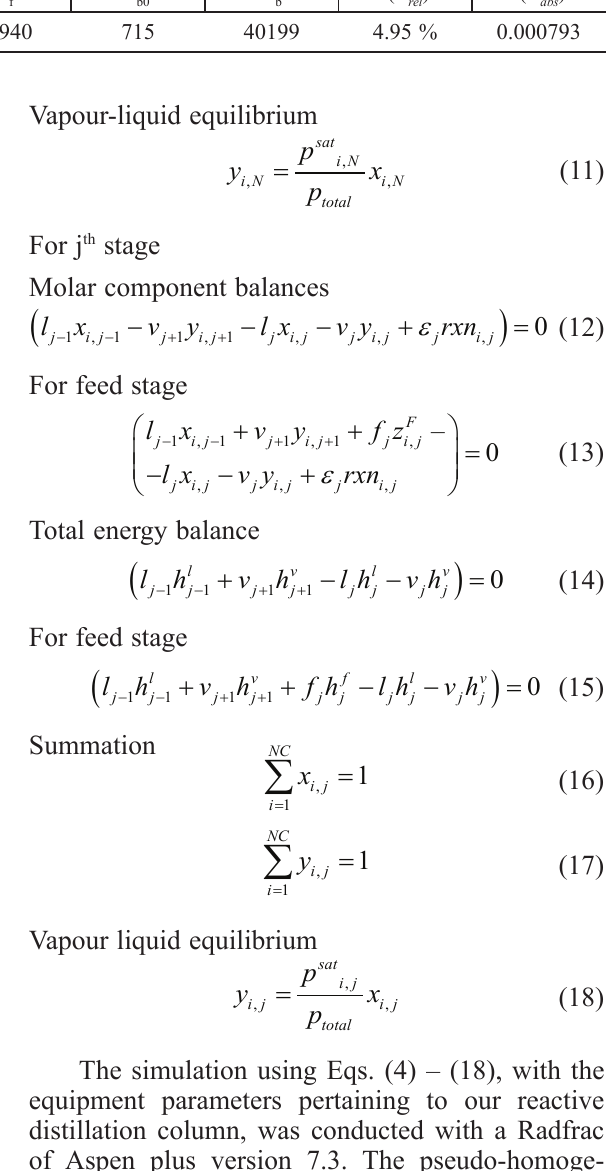
Table 1 – Kinetic parameters for the pseudo-homogeneous (UNIQUAC) model